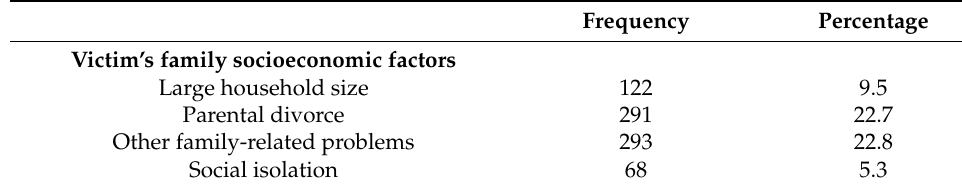
Table 3. Descriptive analysis of the victims’ and perpetrators’ economic-, social-, and environment- associated